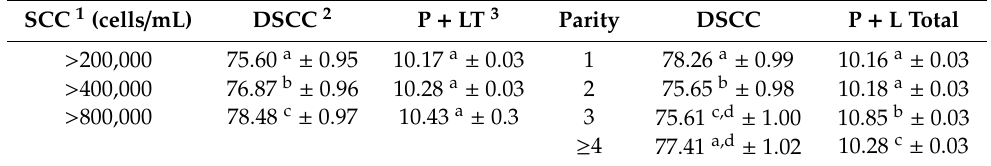
Table 6. DSCC and P + LT mean and standard error in diseased subset ranked by SCC levels and parities. SCC 1 (cells / mL) DSCC 2 P + LT 3 Parity